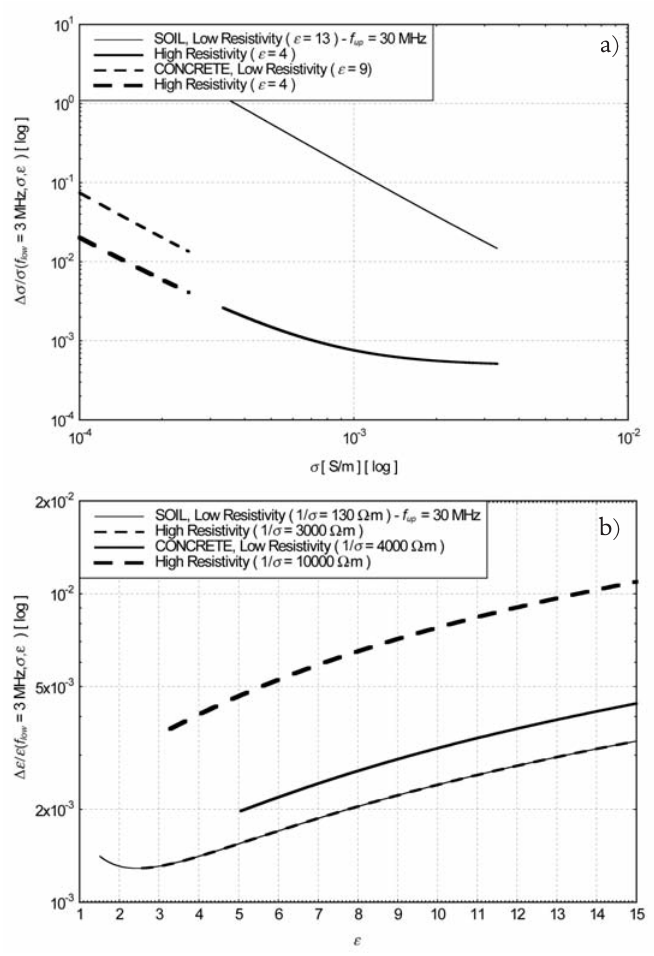
Figure 3. RESPER probe characterized by galvanic contact with a subjacent medium. The RESPER is connected to an ADC which samples in IQ mode and is specified by a minimum bit resolution n = 12, min ensuring measurement inaccuracies below a predefined limit (10%) up to the HF band [Settimi et al. 2010a,b]. The medium can be a variety of concrete or terrestrial soil. Concrete: with low or high electrical resistivity, and respectively high or low relative dielectric permittivity, i.e. (1/ v = 4000 X ·m, f = 9) or (1/ v = 10000 X ·m, f = 4). Soil: with low or high electrical resistivity, and respectively high or low dielectric permittivity, i.e. (1/ v = 130 X ·m, f = 13) or (1/ v (cid:0) = 3000 X ·m, f = 4). The probe performs = 3 measurements at HFs, and the media is analyzed at frequency f low MHz, apart from soils with low resistivity ( f = 30 MHz). The Like-Bode up diagrams of inaccuracy D v / v ( f , v , f ) as a function of v (a) and semi- low,up , v , f ) as a function of logarithmic plots of inaccuracy D f / f ( f low,up permittivity f (b), for both the concrete and